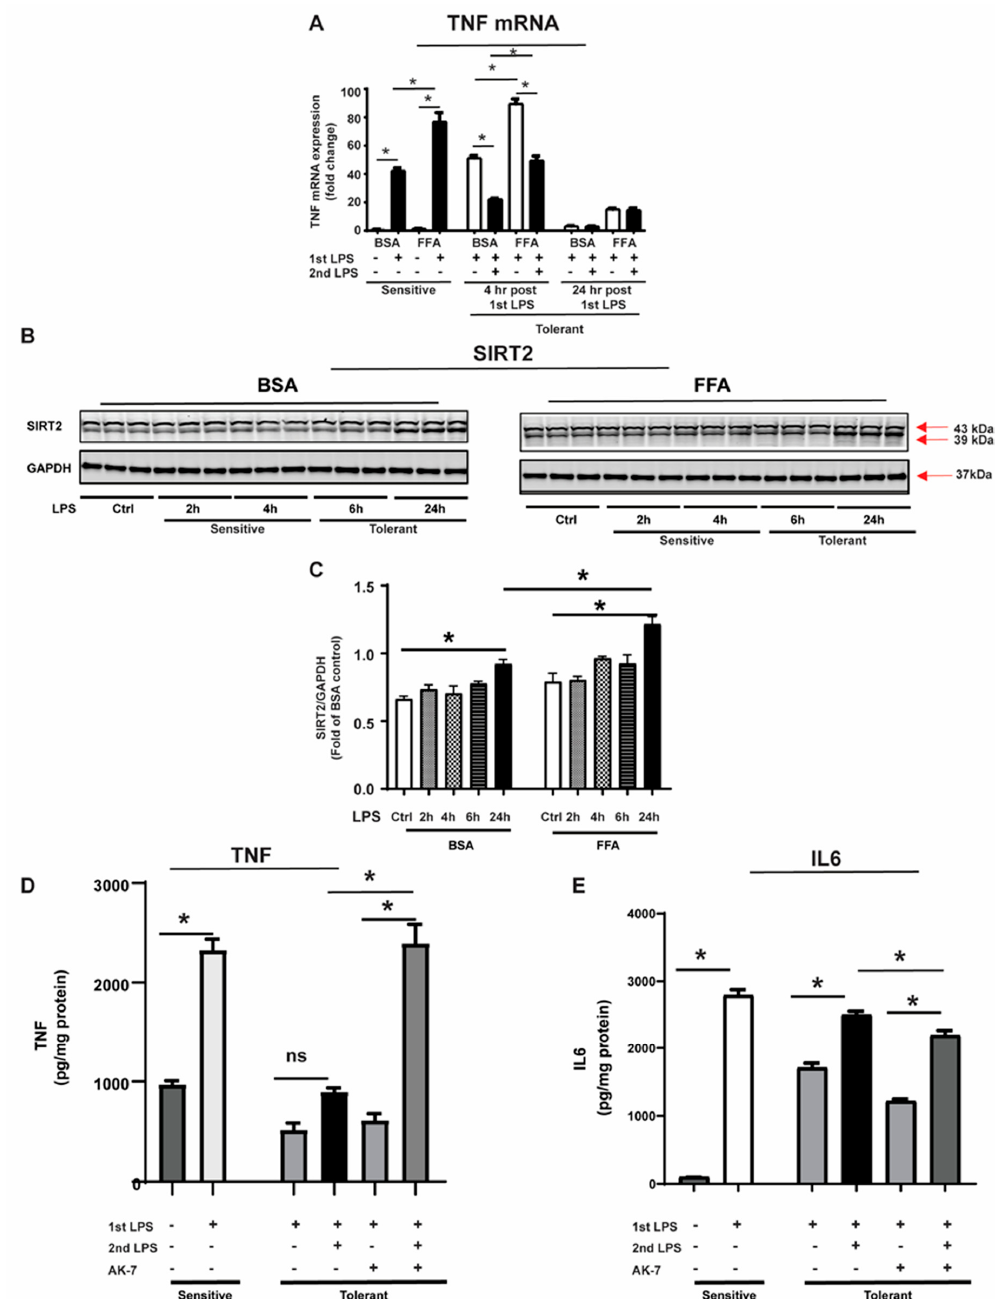
Figure 1. SIRT2 expression is increased in free fatty acid (FFA)-exposed tolerant RAW 264.7 cell macrophages (RAW) cells. Bovine serum albumin (BSA: vehicle for free fatty acid) or stearic acid (free fatty acid: FFA)-exposed RAW264.7 cell macrophages (RAW) were stimulated with either one or two doses of the LPS; second dose at indicated time points after 1st LPS. ( A ) TNF- α mRNA expression was evaluated by qRT–PCR analysis. ( B ) SIRT2 protein expression was detected by Western blot in BSA- or FFA-exposed RAW cells following a single dose of the LPS stimulation for indicated time periods. GAPDH was used as the loading control. ( C ) Western blot image quantification using image-J software (n = 3 each group; * p < 0.05). SIRT2 protein expression was normalized to GAPDH. ( D , E ). To inhibit SIRT2 , after 4 h of 1st LPS exposure, cells were treated with SIRT2 inhibitor AK-7 (25 µM) and incubated further for 20 h in the presence or absence of the second dose of the LPS. TNF- α protein released in the cell culture media from FFA-exposed sensitive and tolerant cells was evaluated by ELISA. (* p < 0.05). IL6 (Figure 1E) protein released in the cell culture media from FFA-exposed sensitive and tolerant cells evaluated by ELISA. (* p <